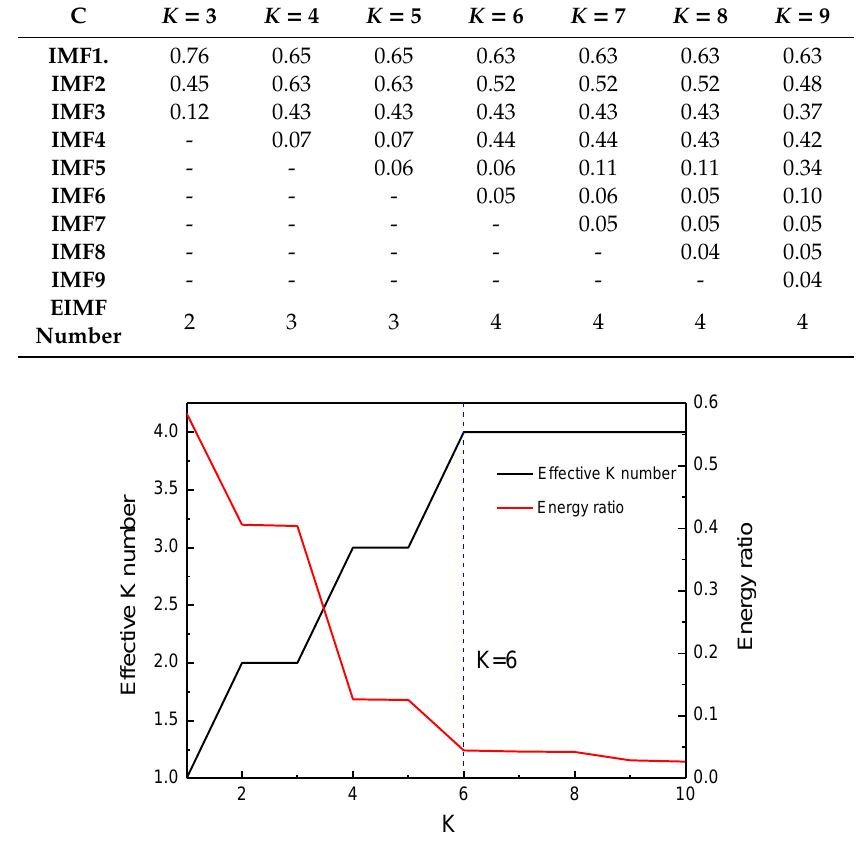
Figure 2. Curves of two main parameters.